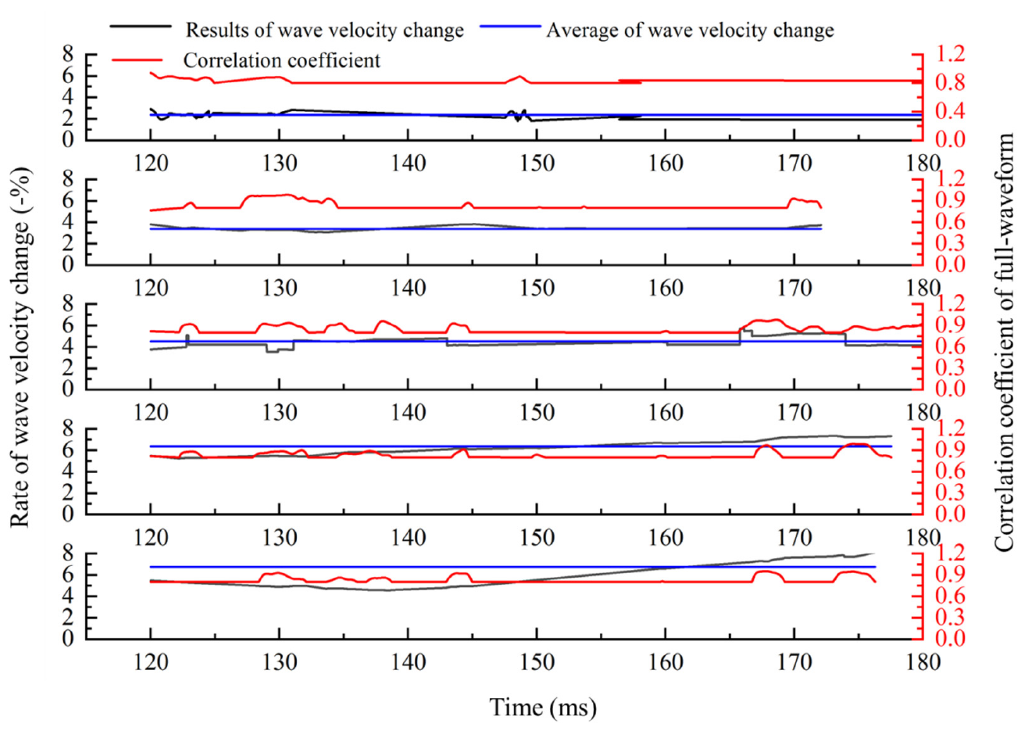
Figure 14. The rate of wave velocity change is calculated with the CWI method. Table 2. The actual and calculated wave velocity change rate calculated with the CWI method.